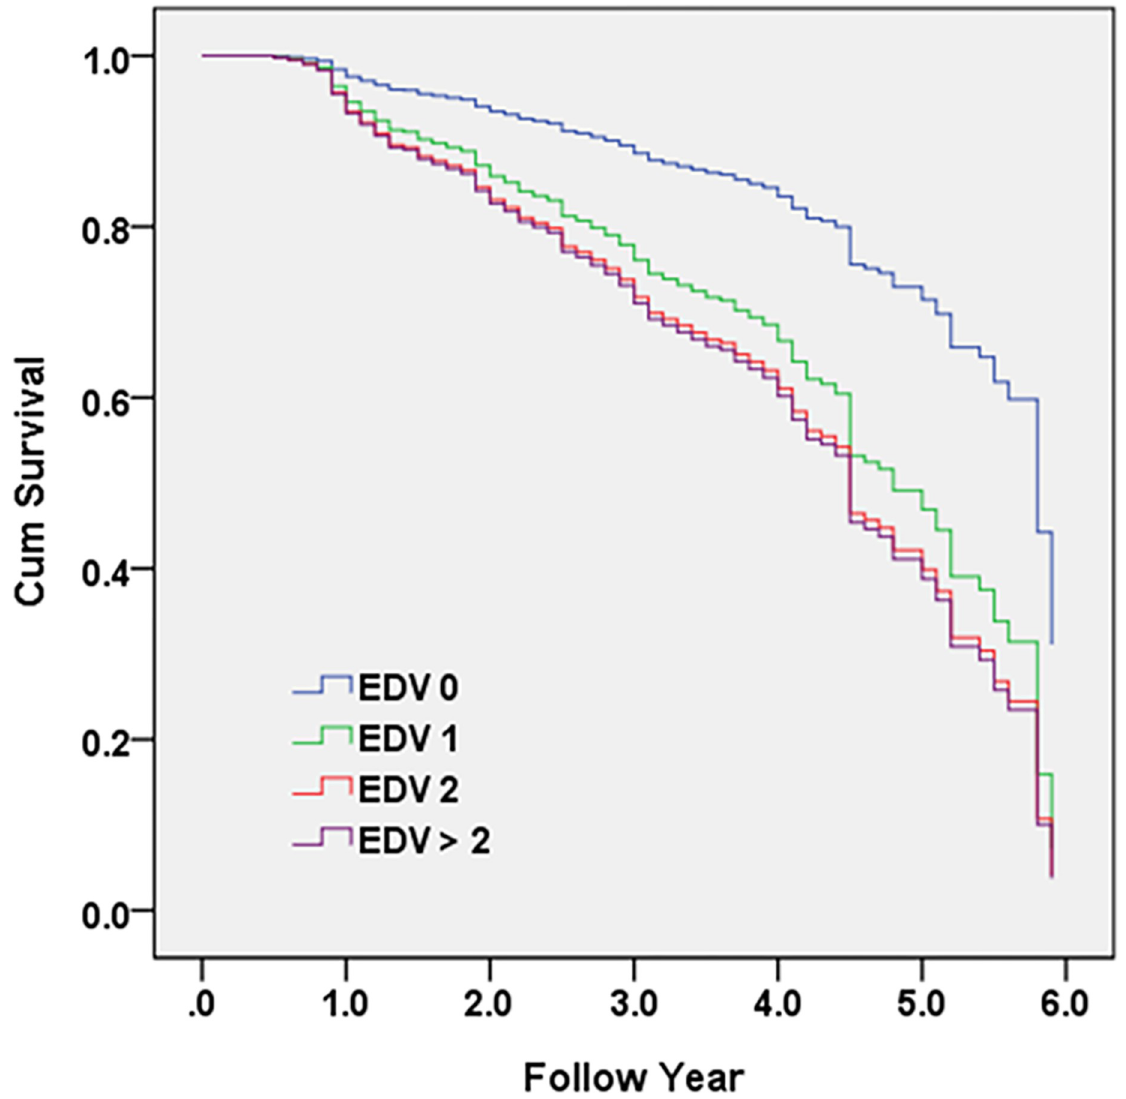
Fig 3. Cox proportional hazards regression was adopted to investigate the contribution of emergency department visits (EDV) among predementia participants to conversion to dementia. Hazard ratios were adjusted for age, sex, education, cognition (CASI), activities